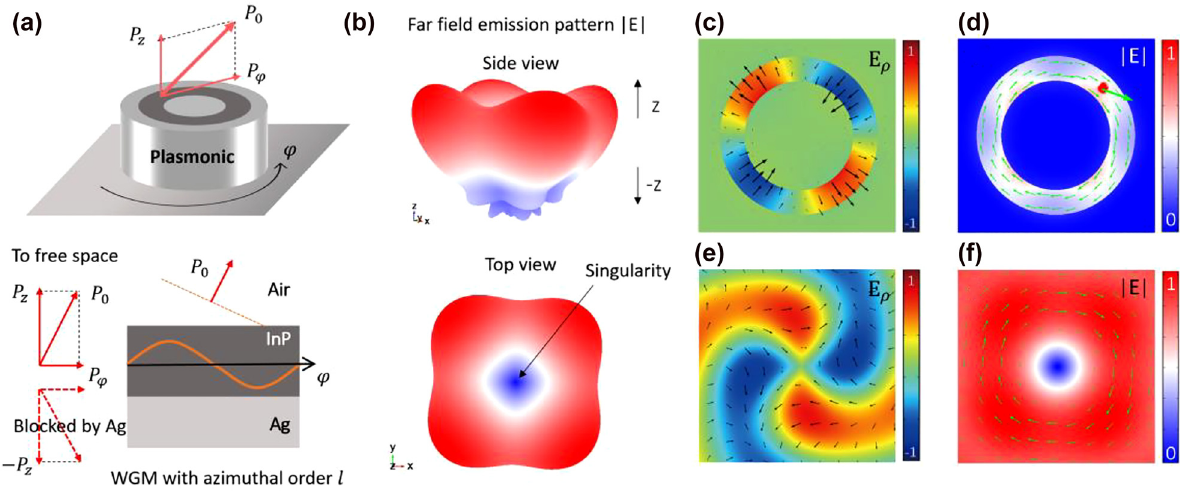
Figure 3: Single emitter vortex radiation at telecommunication wavelength. (a) The device is designed to operate at 1550 nm, where an InAs quantum dot is embedded in the middle InP ring (dark) region. Chiral cavity modewillradiatetofreespaceasvortexbeamfromtheopenfacetofthenanocavity. P 0 , P z ,and P φ representthetotalmomentumandits z and azimuthalcomponents,respectively.(b)Simulatedperspectiveview(upperpanel)andtopview(bottompanel)ofthefar fi eldradiationpattern ofthedevice.(c) – (f) E ρ and | E | ofthesingleemitterexcited fi eldinsidethecavity((c)and(d))andataheightof1550nmabovethecavity((e)and (f)). In (c) – (e), the black and green arrows denote polarizations and Poynting vectors, respectively. In (f), the green arrows denote azimuthal component of Poynting